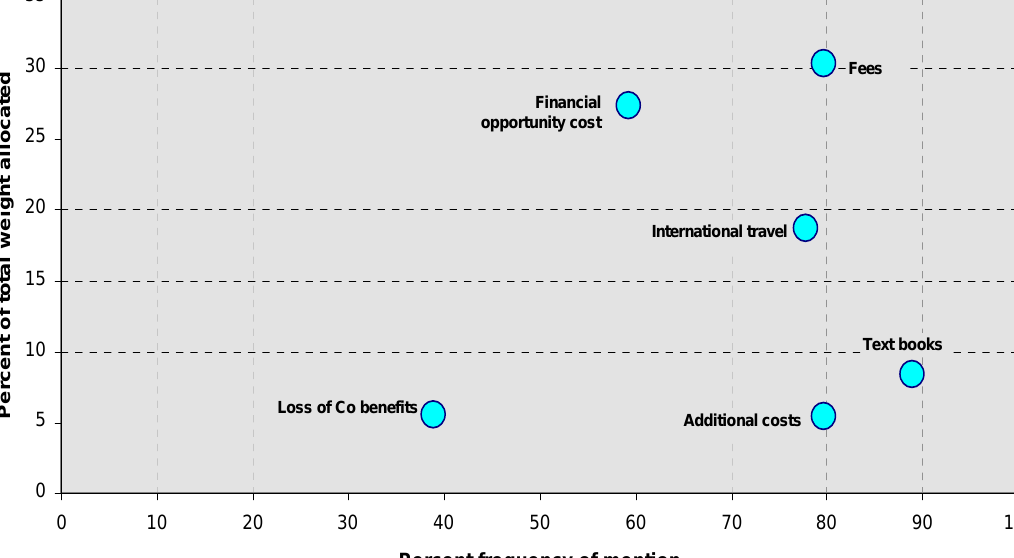
Figure 4: The perceived financial costs of an